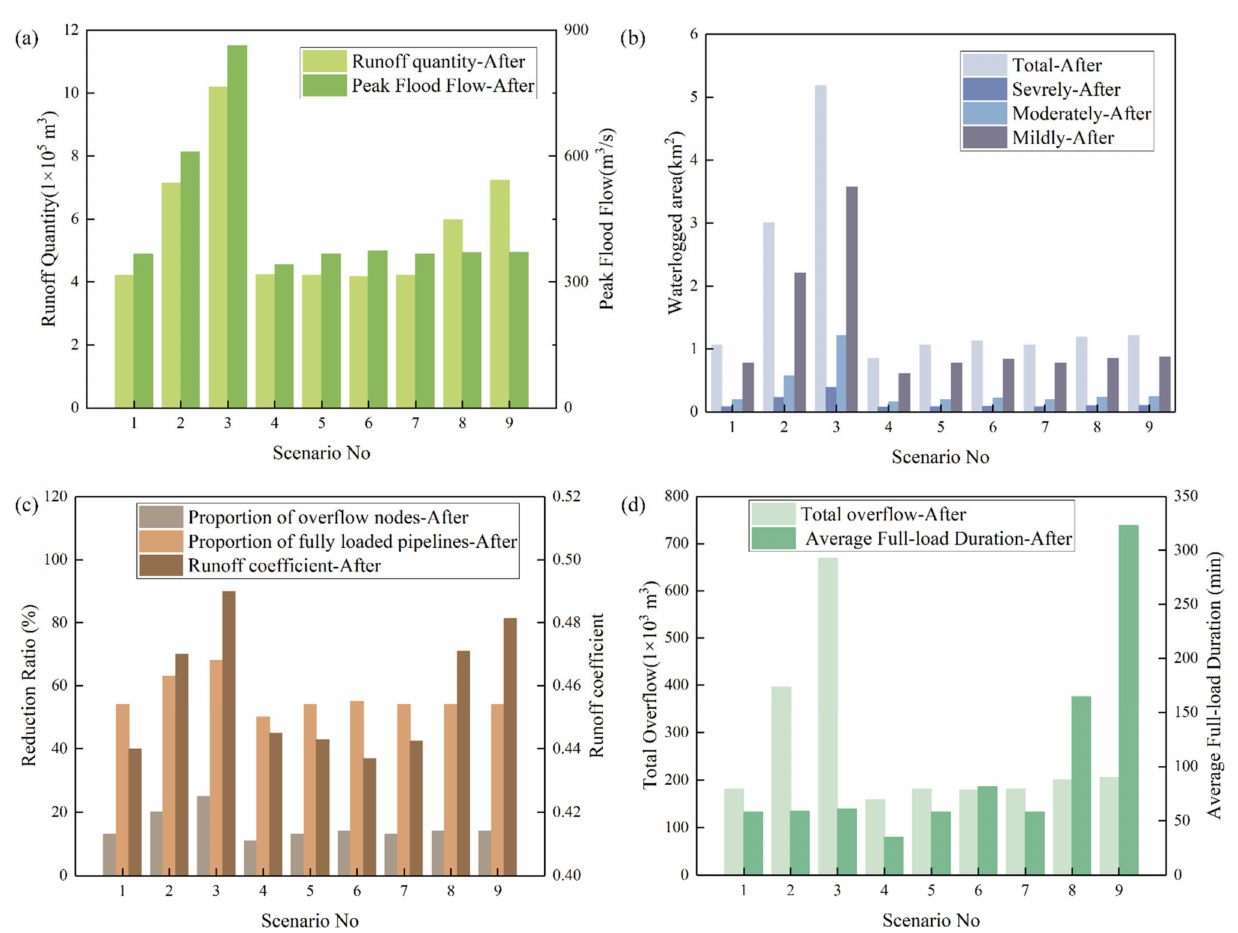
Figure 11. Change in the surface runoff, waterlogged area, and drainage network indicators under different rainfall patterns. ( a ) flow indicators (runoff quantity, peak flood flow); ( b ) waterlogged area indicators; ( c ) drainage network indicators (proportion of overflow nodes, proportion of fully loaded pipelines, runoff coefficient); ( d ) drainage network indicators (total overflow quantity, average full-load